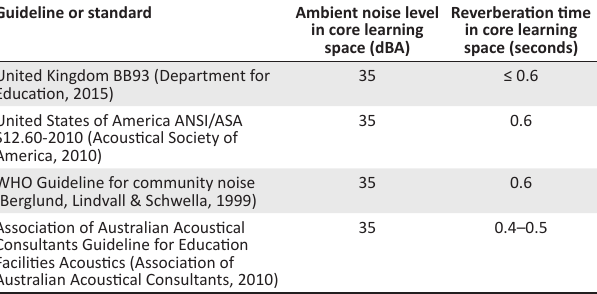
TABLE 1: Selected international acoustic